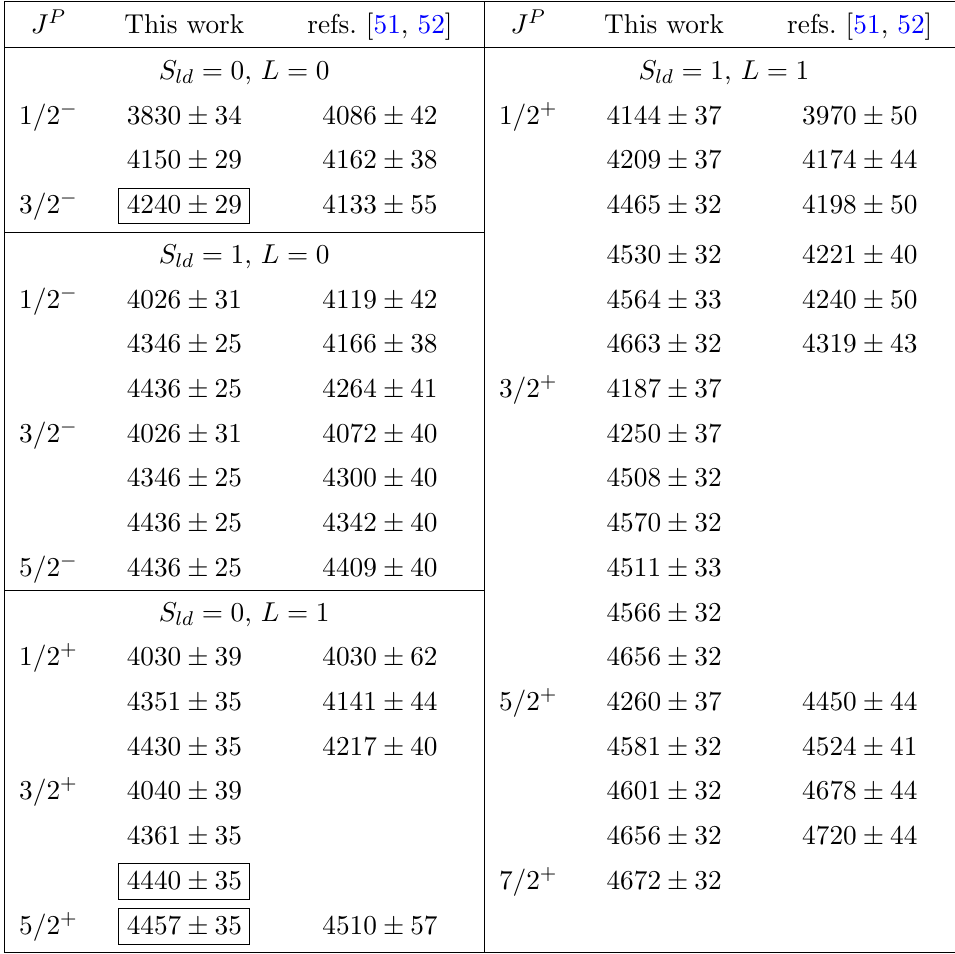
Table 8 . Masses of the hidden-charm un(cid:13)avored pentaquarks (in MeV) and their comparison with the results presented in [51, 52]. For the P -wave pentaquarks, the values of the orbital, spin-orbit and tensor couplings are taken from table